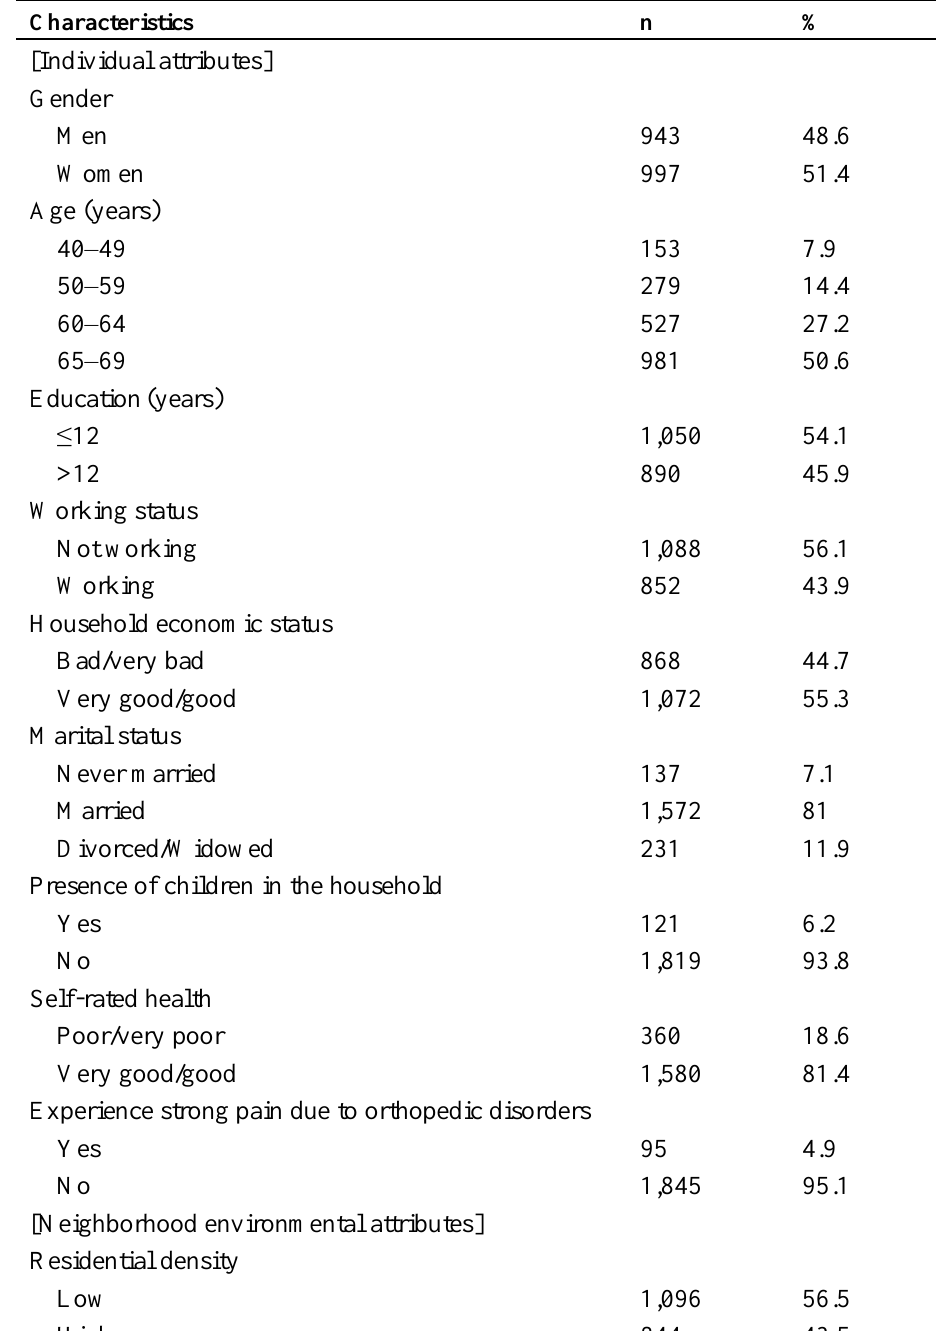
Table 1. Distribution of individual and neighborhood environmental attributes entered into the final logistic regression model (n =